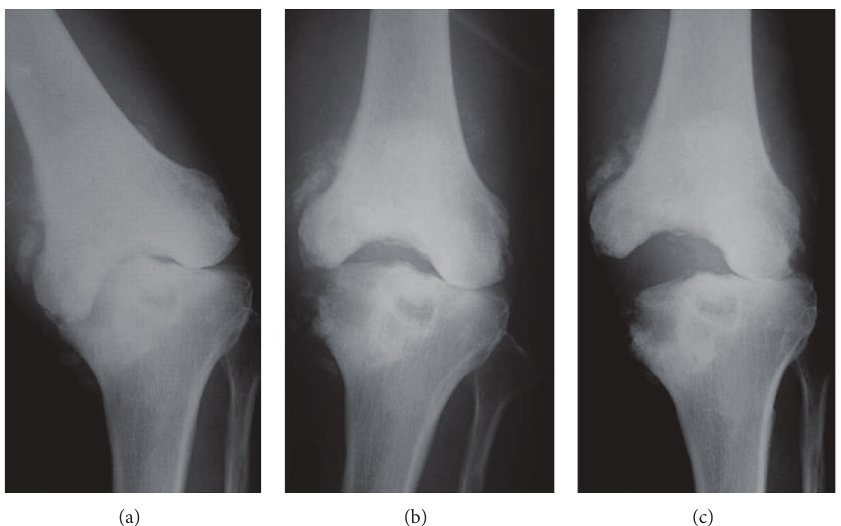
Figure 2: Stress radiographs of the left knee before the primary total knee arthroplasty (TKA) ((a) varus stress, (b) neutral, and (c) valgus stress). Severe joint destruction and instability are seen, indicating neuropathic arthropathy.